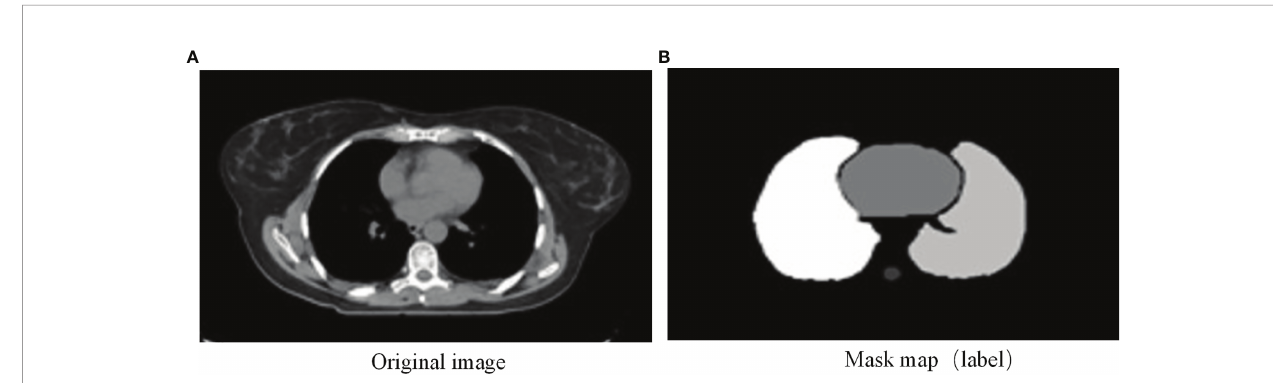
FIGURE 1 | (A) Original image and (B) mask map (label).